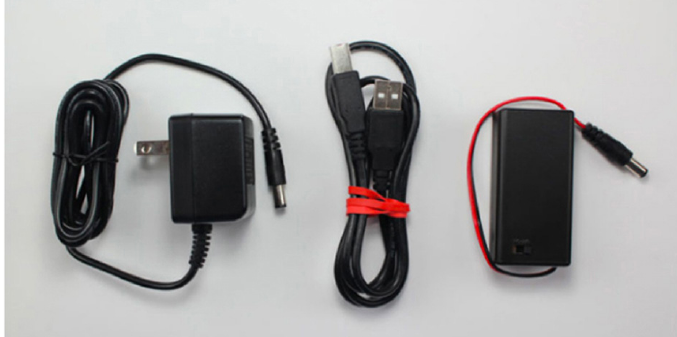
Fig. 6. USB Cables for supply of Arduino Uno